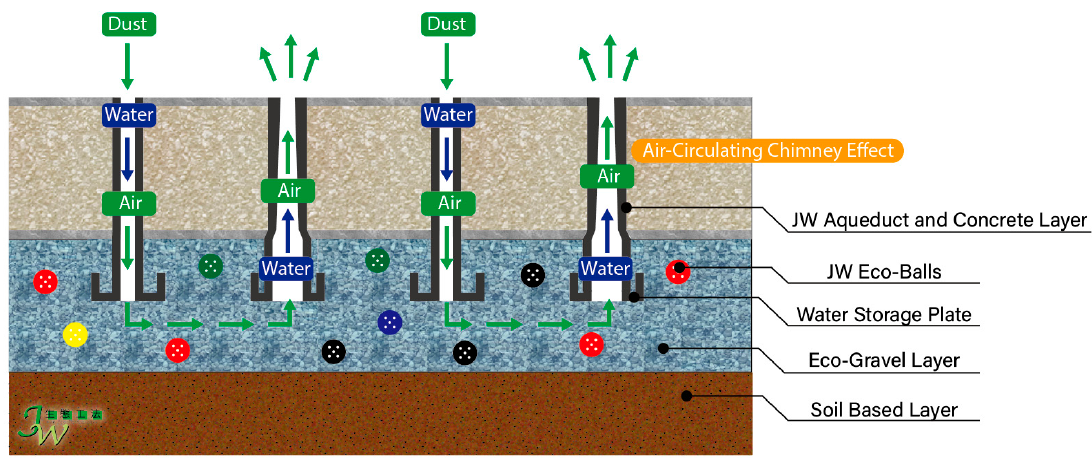
Figure 2. A typical pavement design using the JW Eco-technology method (courtesy of JW Eco- technology, Ding Tai, Co., Ltd., New Taipei City, Taiwan).